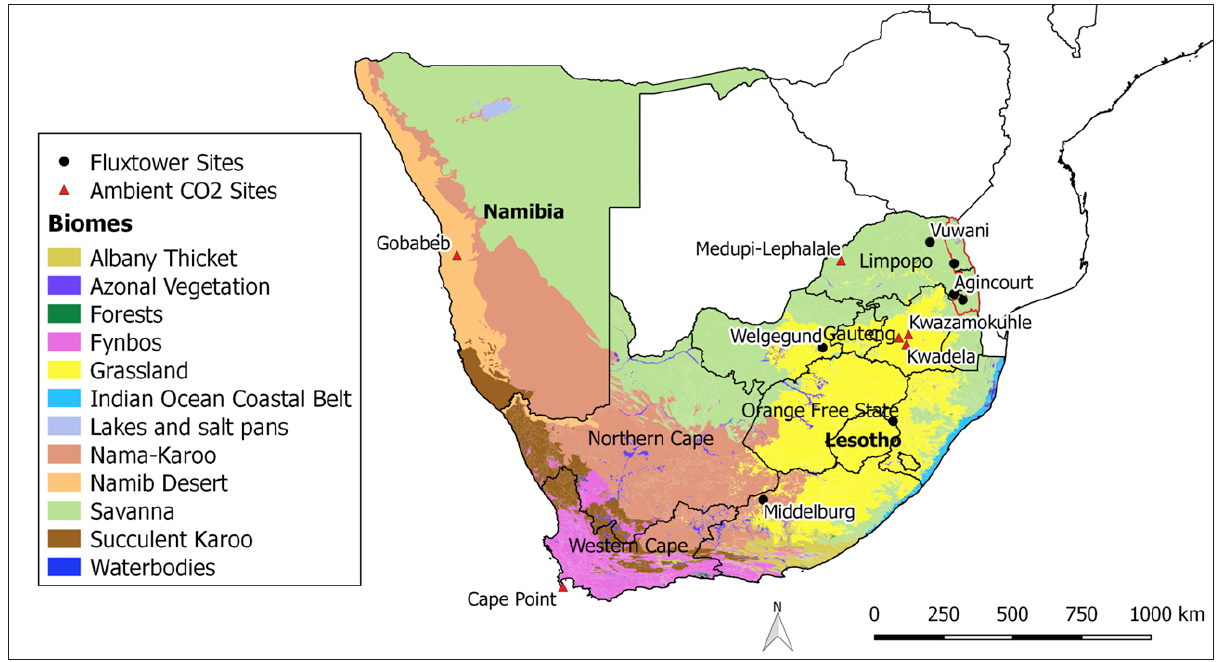
measurements in South Africa including both the flux tower locations and the CO 2